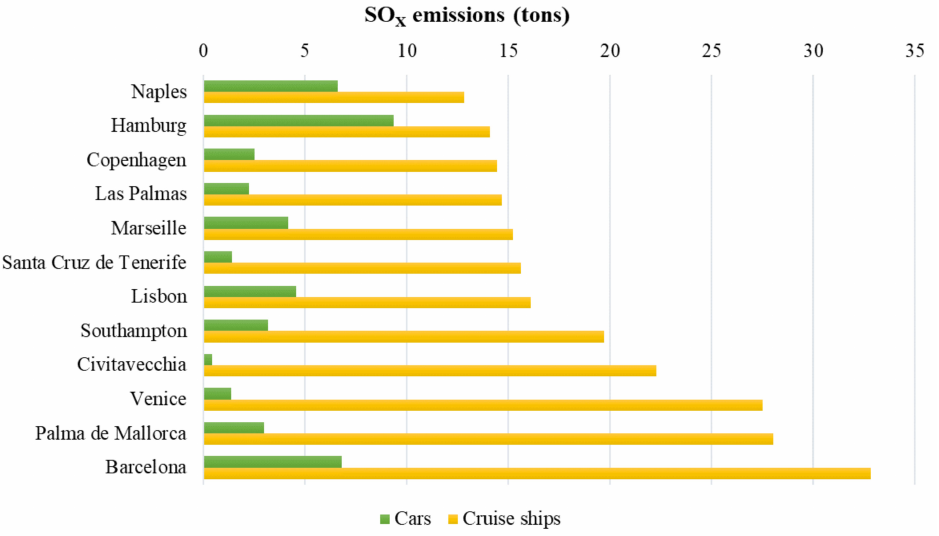
Figure 1. Yearly SO X emissions from cruise ships and cars in some harbour cities in Europe in 2017. Adapted data from